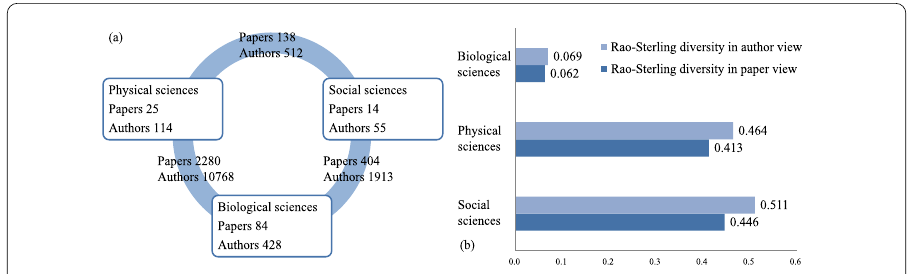
Figure 5 The interdisciplinary research of PNAS 1999–2013 between and within biological, physical and social sciences. Panel ( a ) shows the proportions of papers and those of authors involved in dyadic interactions between the three science categories, and those proportions involved in interactions within each science category. Panel ( b ) shows the Rao-Sterling diversity in paper/author view of each science category,